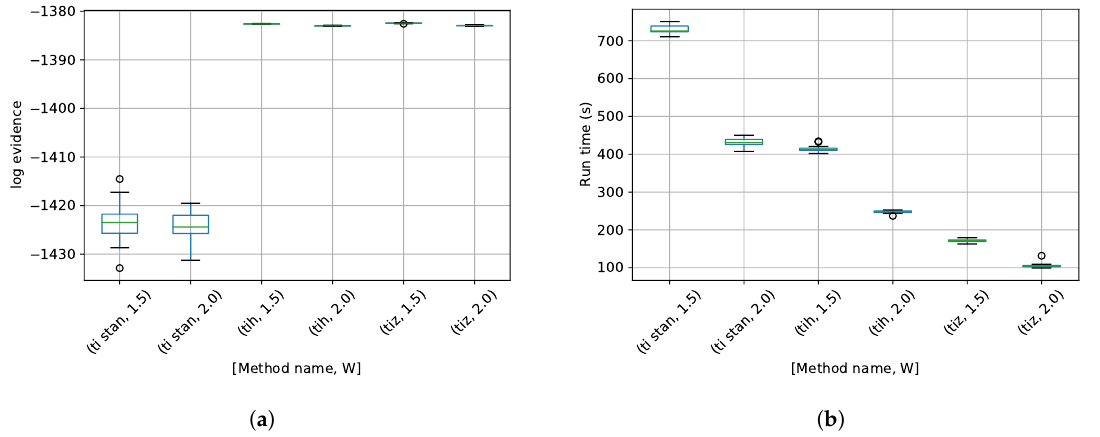
Figure 2. MSF model with J = 1 results. ( a ) Box-plot of log-evidence for the one stationary frequency model for TI-Stan, TI-BSS-H, and TI-BSS-Z, for two values of W ; ( b ) Box-plot of run time for the one stationary frequency model for TI-Stan, TI-BSS-H, and TI-BSS-Z, for two values of W .